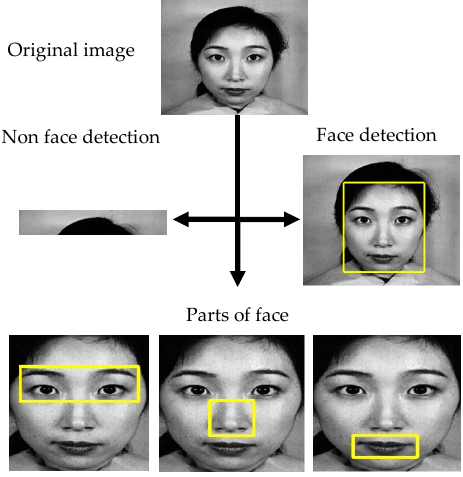
Figure 2. Detecting features of facial regions using the Viola-Jones